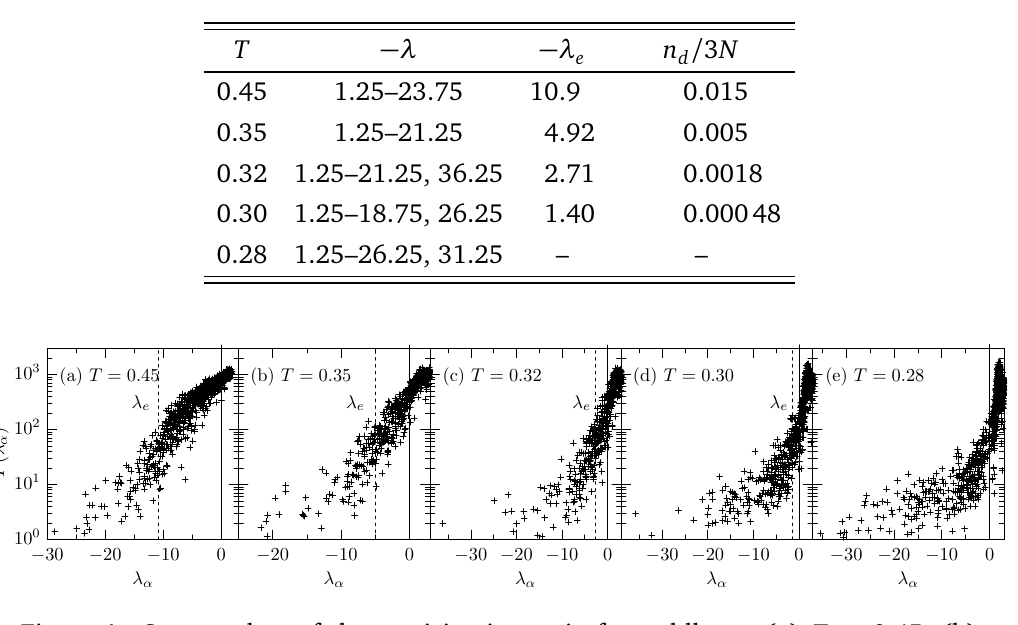
/ ( 3 N ) at all investigated d